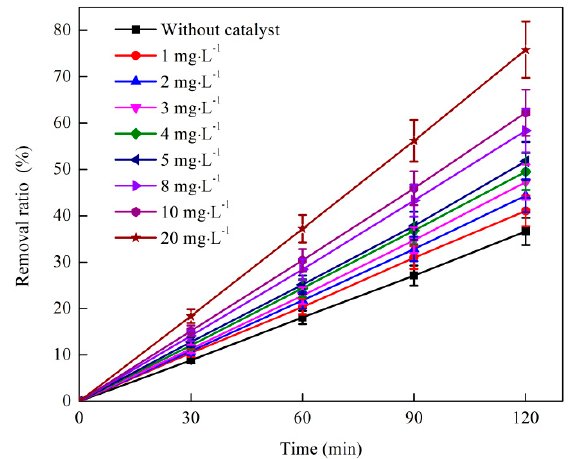
Figure 6. Effect of H 2 O 2 dosage on coking wastewater treatment by O 3 catalytic